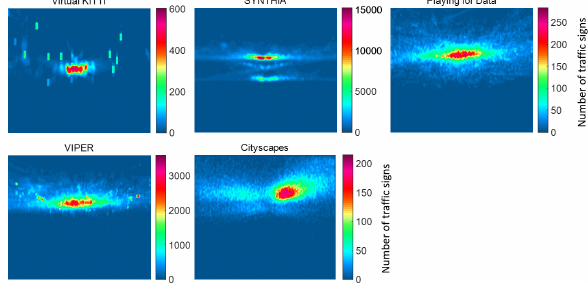
Figure 5. Heatmaps showing the distribution of traffic signs in the synthetic images of different datasets. The distributions are derived from the semantic ground truth images. The heatmap of the real-world dataset Cityscapes is given as